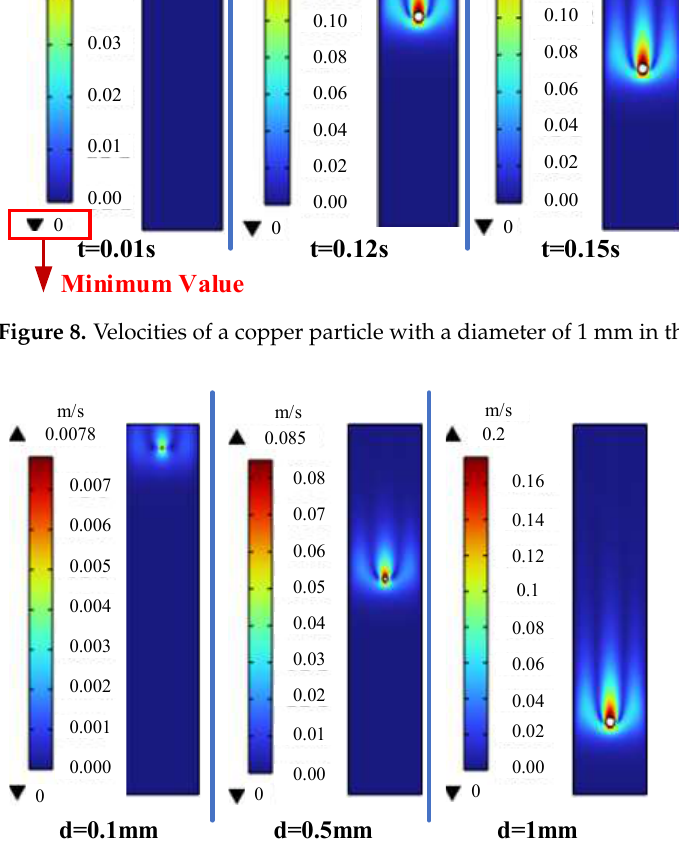
Figure 9. Velocities of copper particles with different diameters at t = 0.2 s.